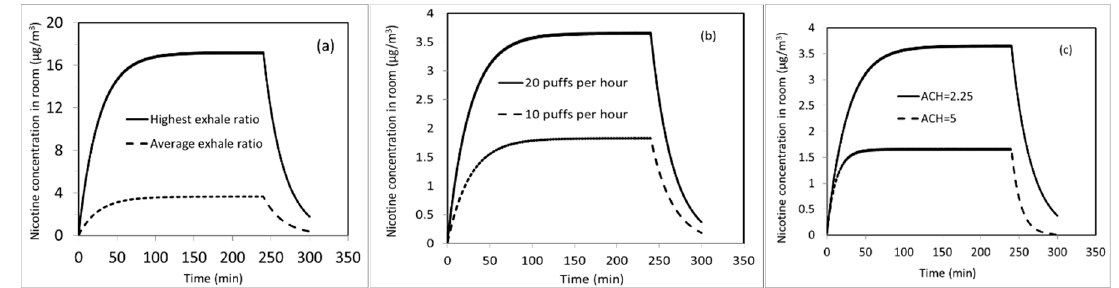
Figure 8. Effects of ( a ) exhaled nicotine ratio; ( b ) number of puffs taken by each participant; ( c ) air exchange rate (ACH) on predicted indoor air nicotine concentration.